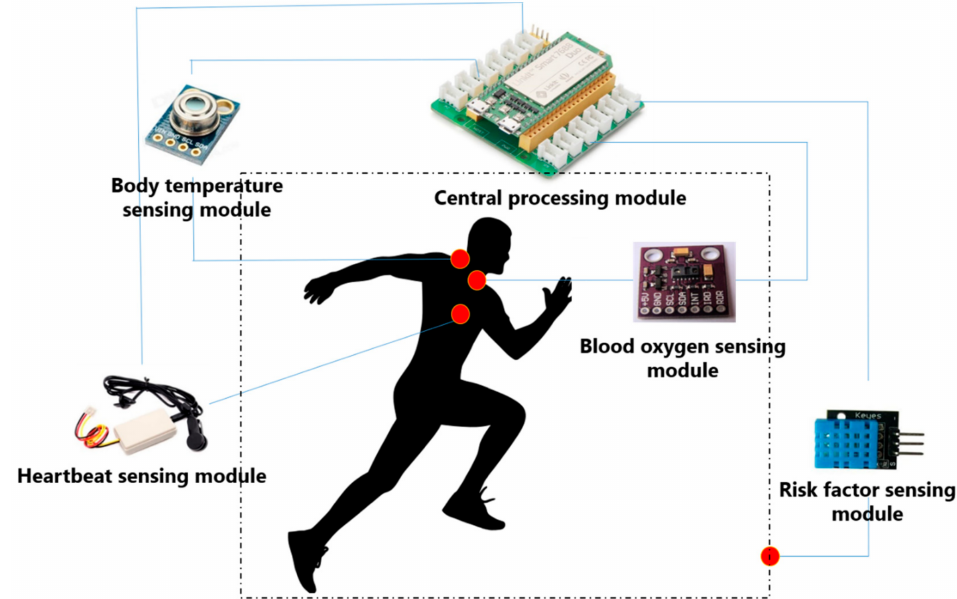
Figure 4. Fitness management device schematic.